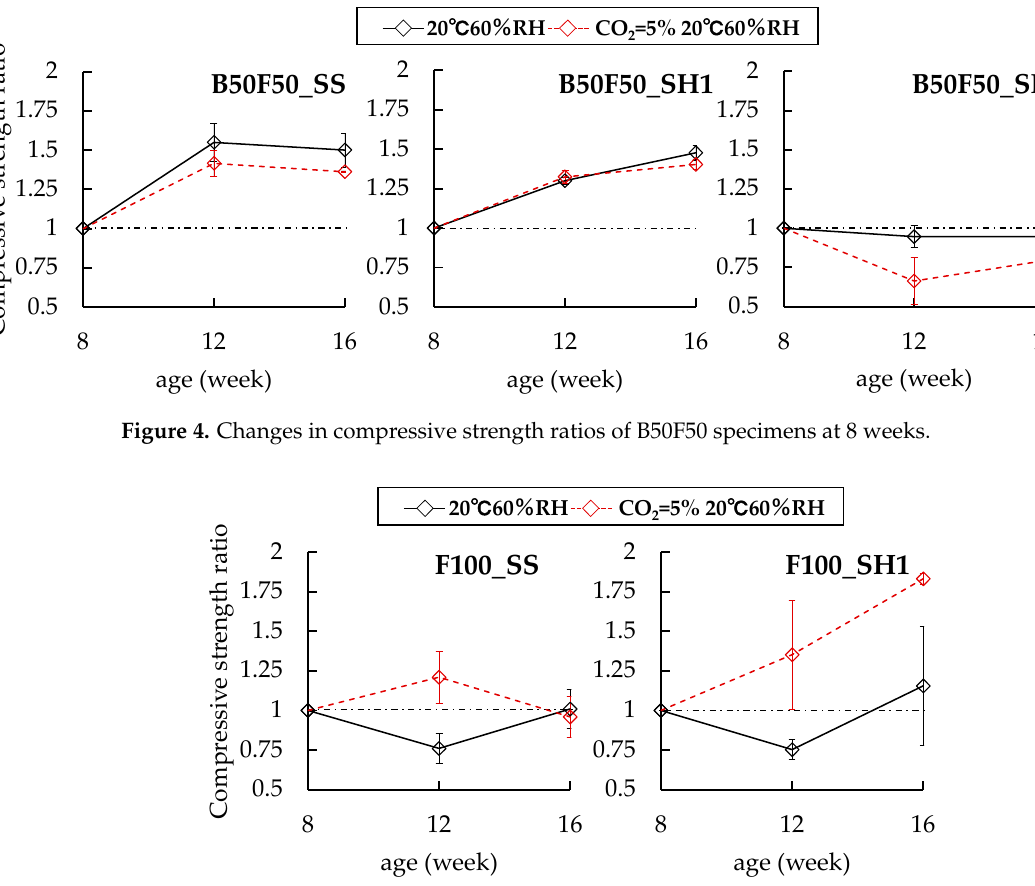
Figure 5. Changes in compressive strength ratios of F100 specimens at 8 weeks.